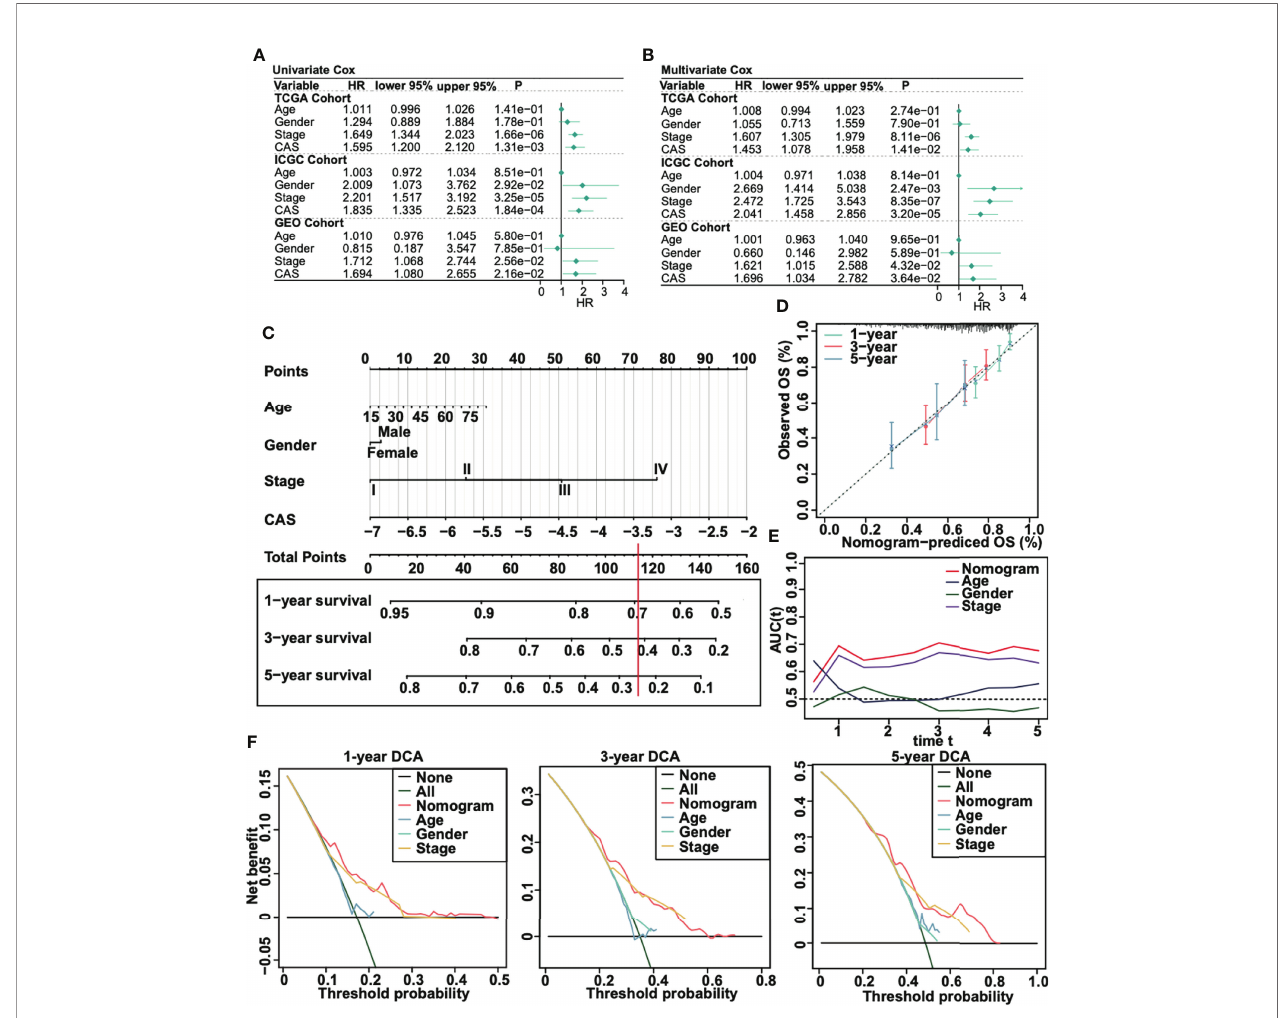
FIGURE 4 | Creation of a nomogram for patients with HCC. (A) Univariate Cox regression in TCGA, ICGC, and GSE75427 cohorts. (B) Multivariate Cox regression in TCGA, ICGC, and GSE75427 cohorts. (C) Constructed nomogram based on CAS. (D) One-, 3-, and 5-year calibration curves were generated. (E) AUC analysis between the constructed nomogram and parameters was performed. (F) One-, 3-, and 5-year DCA was